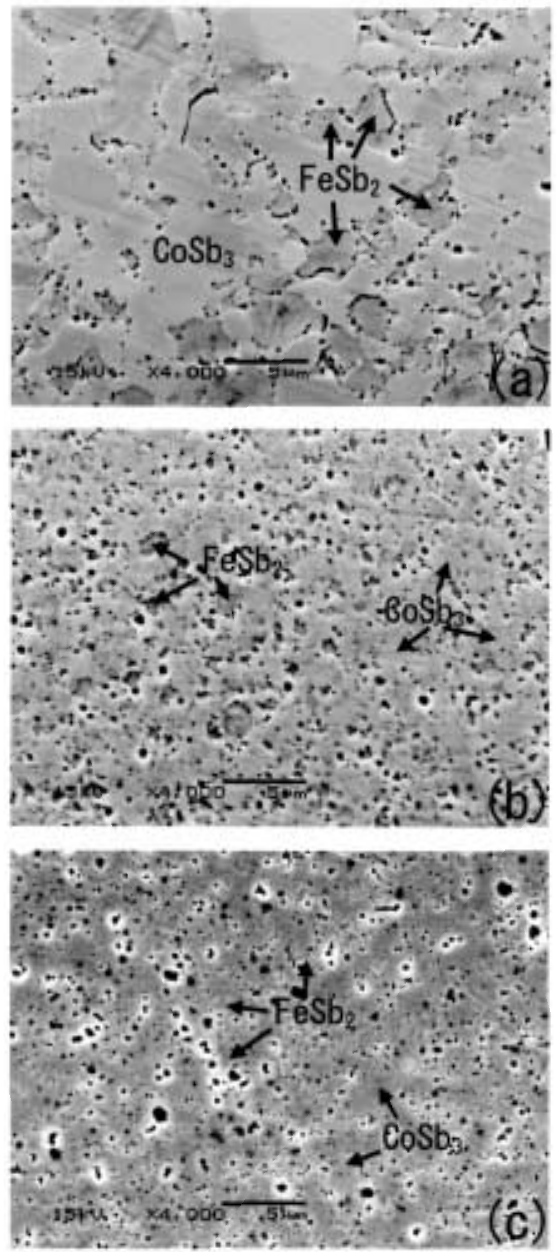
Fig. 10 SEM photographs for the sintered CoSb 3 -FeSb 2 compos- ite whose molar ratio of CoSb 3 to FeSb 2 is 0.6:0.4. (a)MG 30min, (b)MG 7h and (c)MG